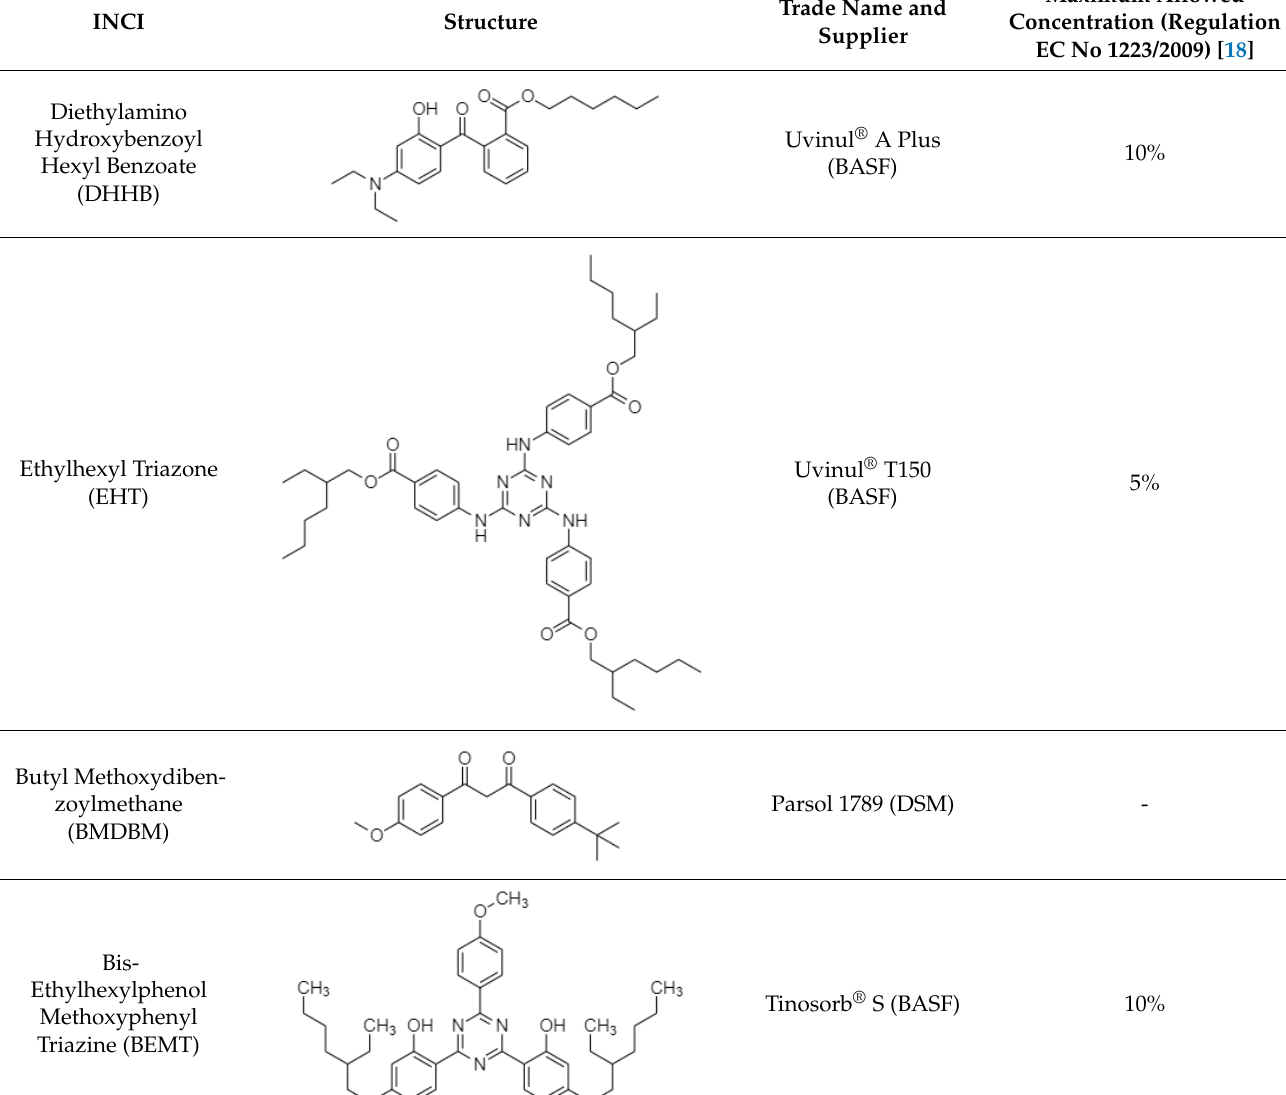
Table 2. INCI name, structure, trade name and supplier of UV filters used.